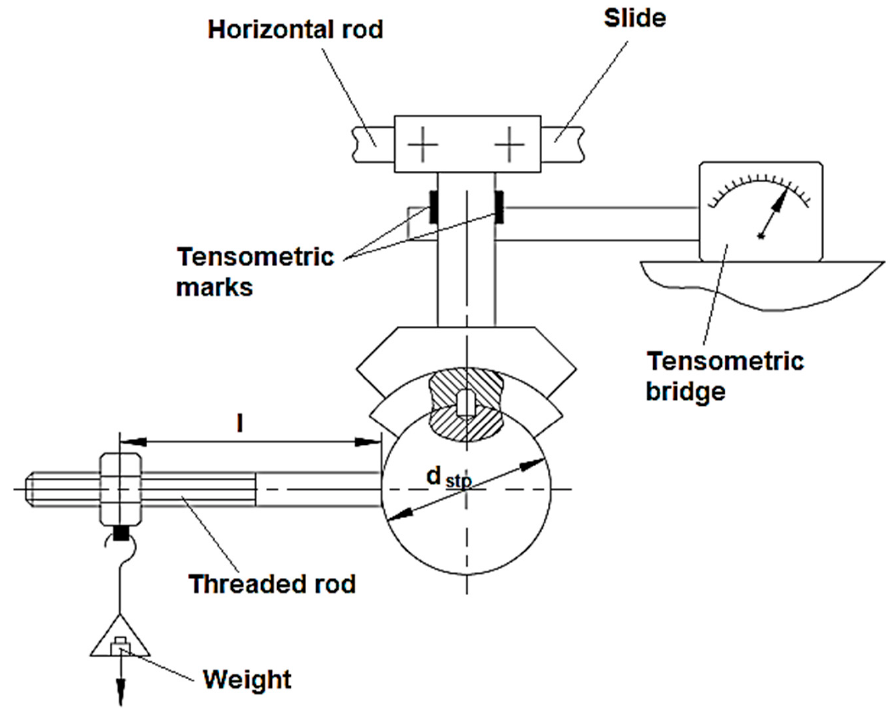
Figure 3. Calibration of equipment for studying the wear behavior of surfaces obtained by different processing methods.